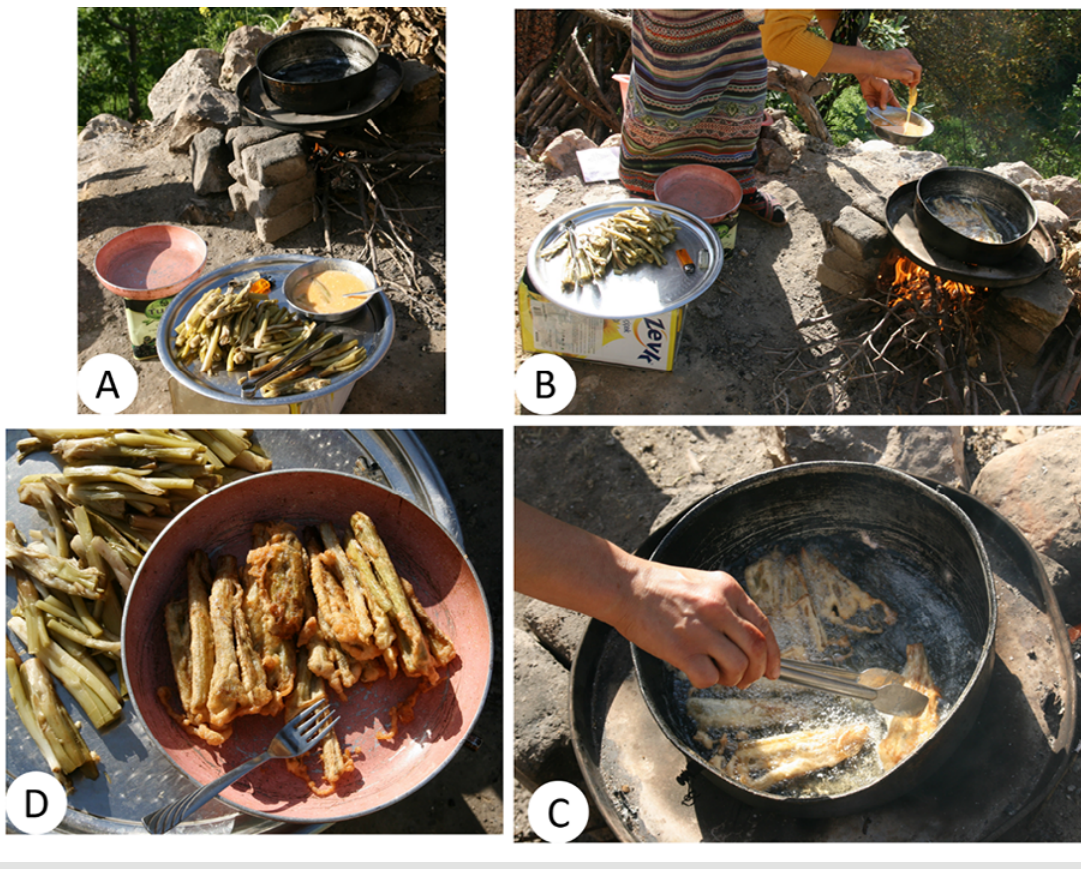
Fig. 9 The cooking of brined parts of Gundelia tournefortii